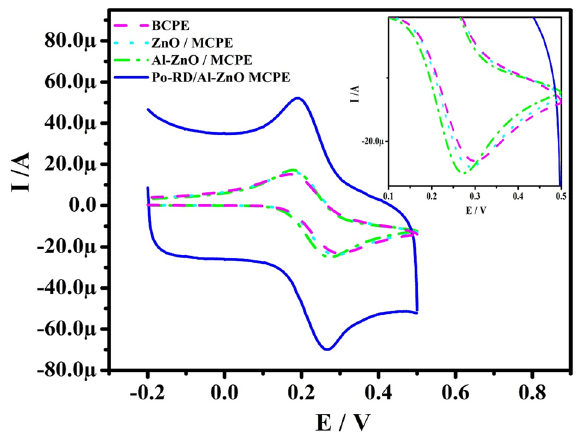
Figure 5. CVs of 1 mM potassium ferrocyanide in 1 M KCl at speed rate 50 mV s −1 .